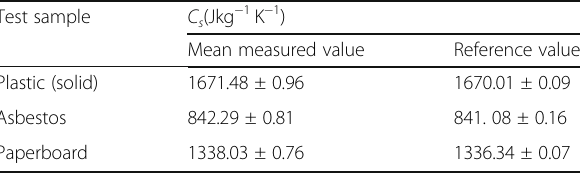
Table 2 Values of specific heat capacity of the test sample